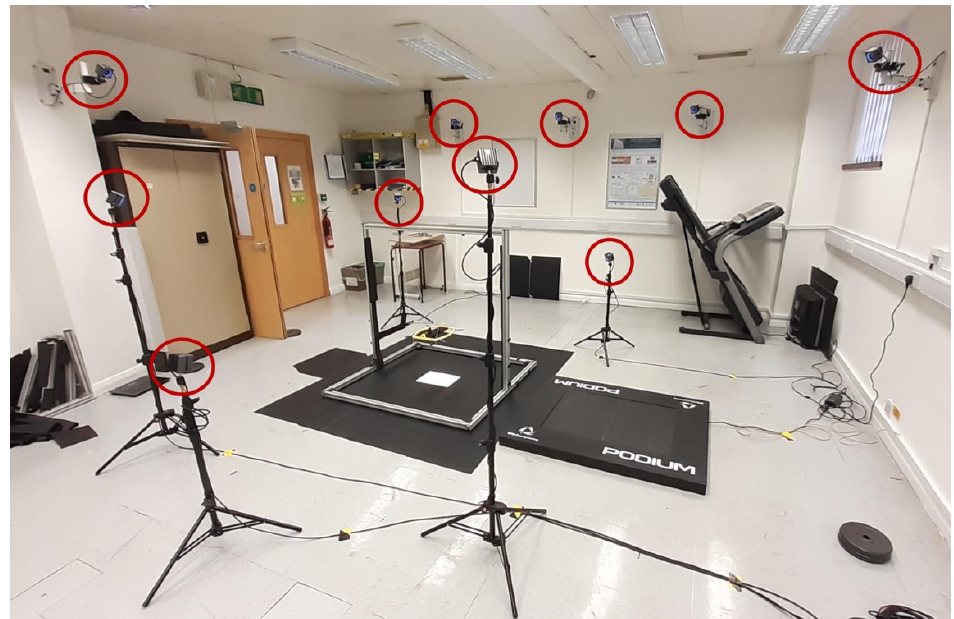
Figure 10. Positioning of the MoCap system cameras in relation to the device. Cameras are high- lighted with red circles.